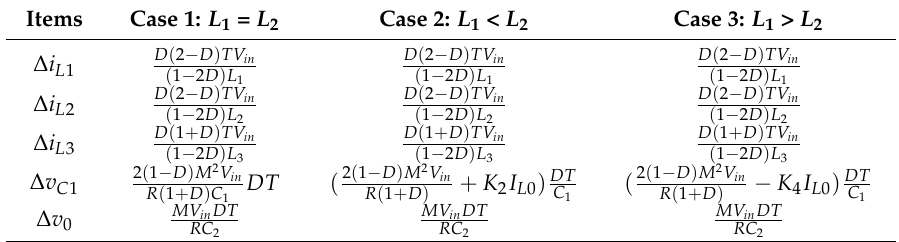
Table 3. Ripples for inductor currents and capacitor